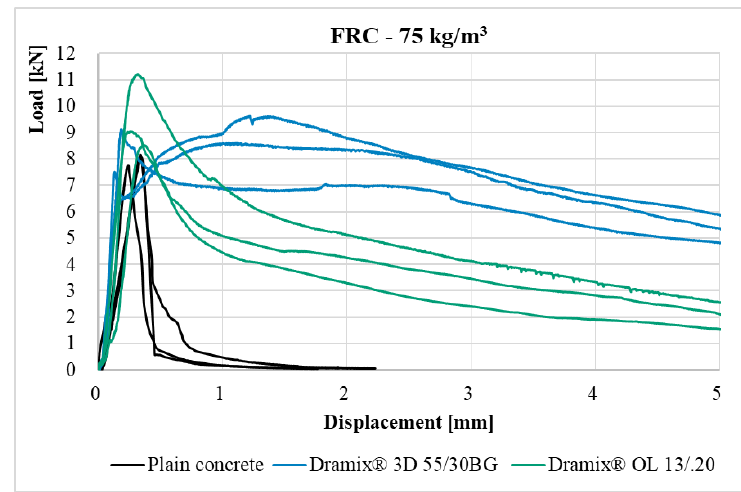
Figure 14. Load–displacement diagrams for plain concrete and fiber-reinforced concrete with a fiber dosage of 75 kg/m 3 . Crystals 2020 , 10 , x FOR PEER REVIEW 14 of 21